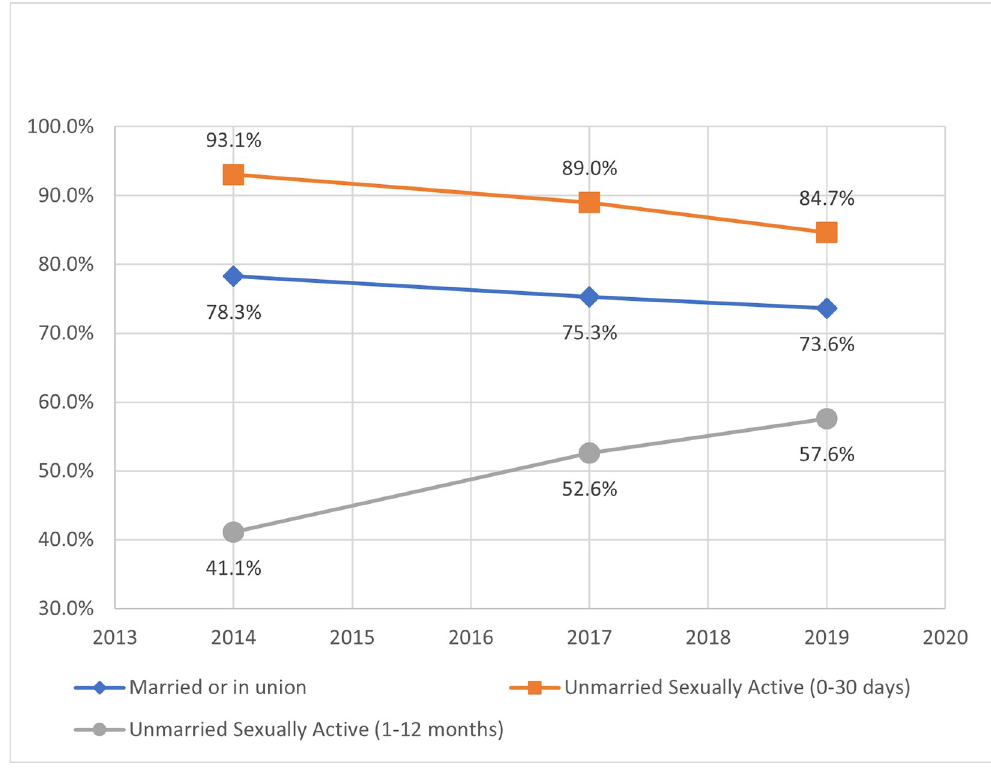
Fig 5. Total demand for modern contraceptives by female